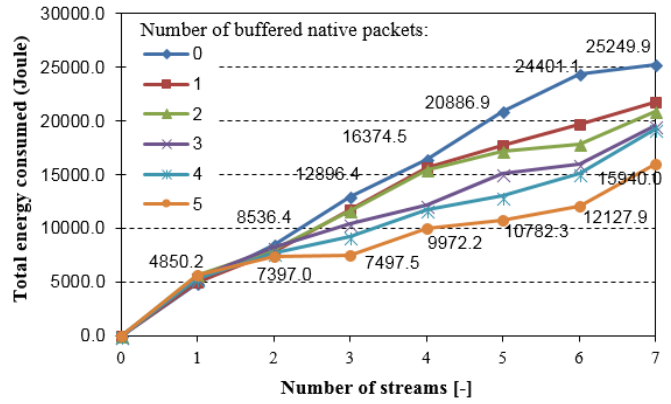
Figure 13. Total energy consumed in the network for packets transmission and reception (extended testing scenario).